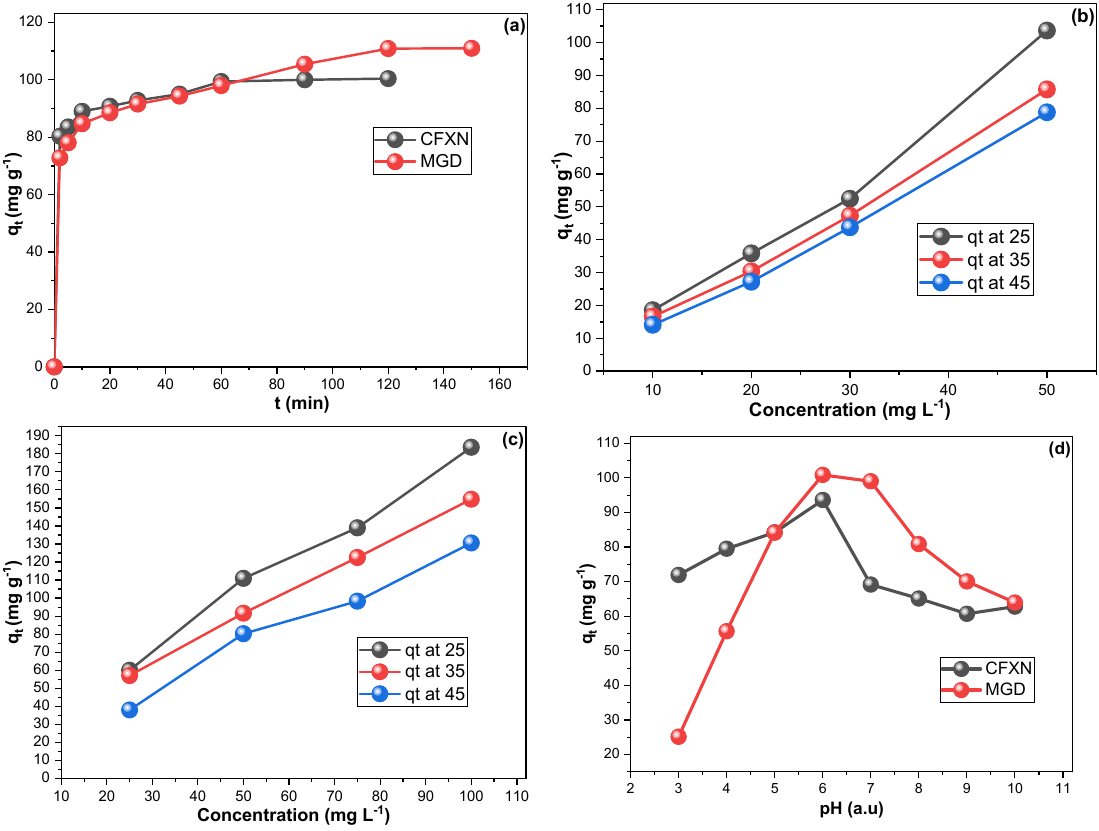
Figure 4. CFXN and MGD adsorption using CNPs, investigations of ( a ) the contact time study; ( b , c ) the impact of initial pollutant concentration on the adsorption of CFXN and MGD; and ( d ) the influence of the solution’s pH.